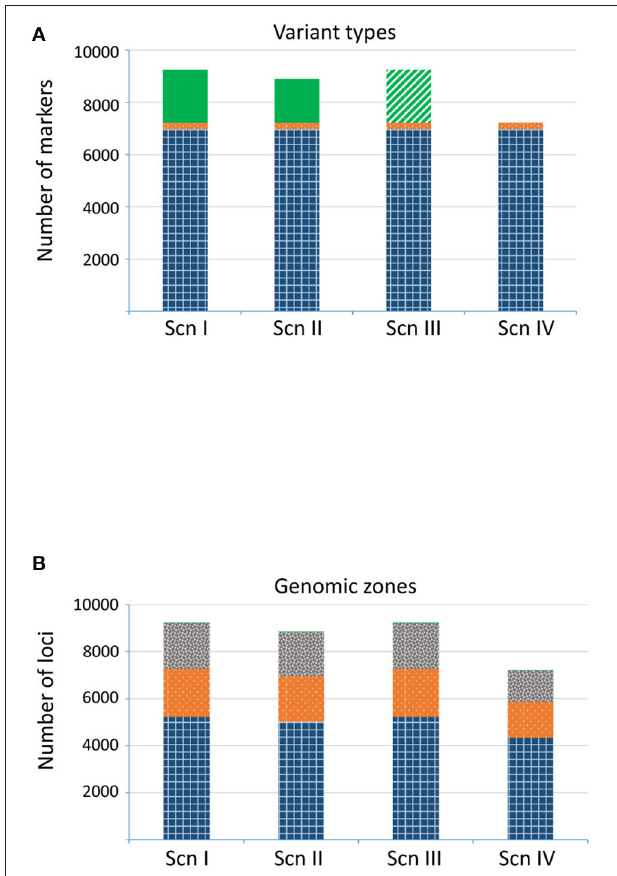
FIGURE 4 | Number of loci detected for each scenario. (A) Variant types: SNP (gridded blue), indel (dotted orange), and imputed loci (plain green; treated as missing data in ScnIII). (B) Genomic region: known exonic region (gridded blue), known intronic region (dotted orange), intergenic region (gray confetti), not assigned region (plain